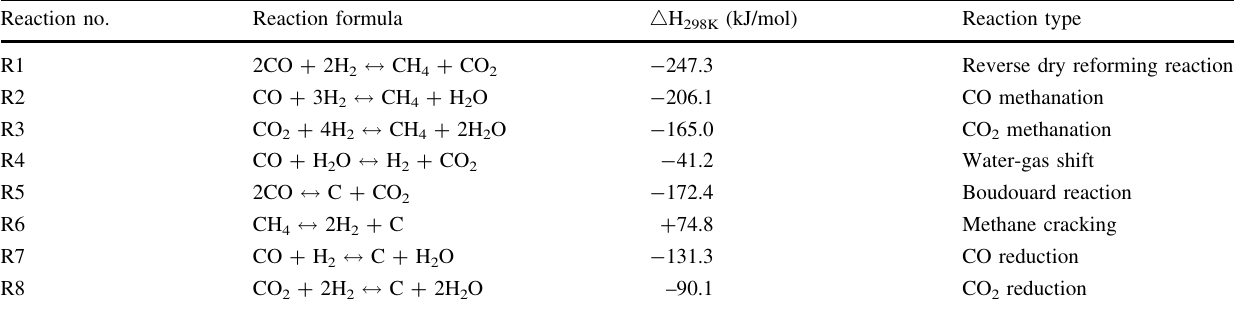
Table 1 The relevant reactions in the reverse dry reforming reaction Reaction no.